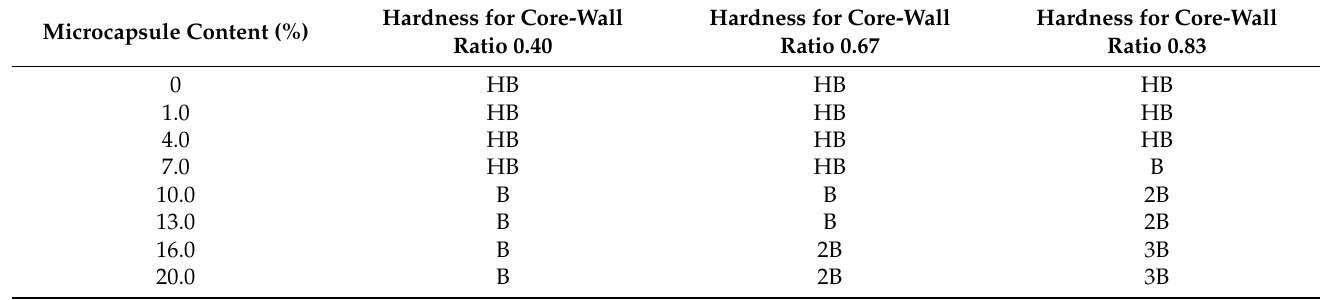
Table 5. Hardness test